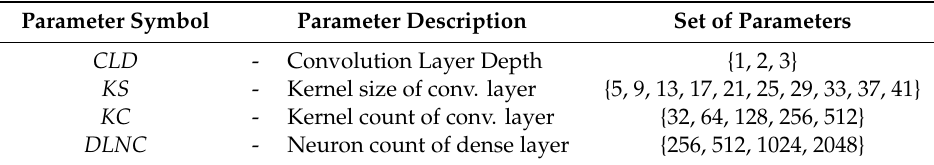
Table 2. The parameters used in the proposed method.